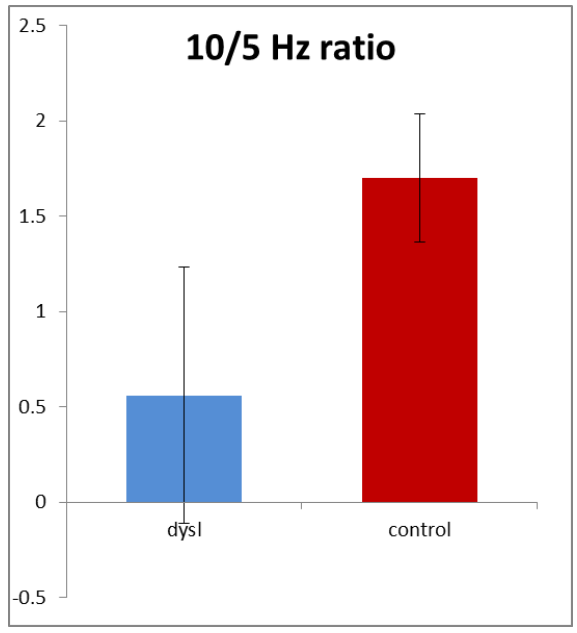
Figure 4. The 10/5 Hz ratio (+/−1 sd). Dyslexic n = 68; control n = 88.